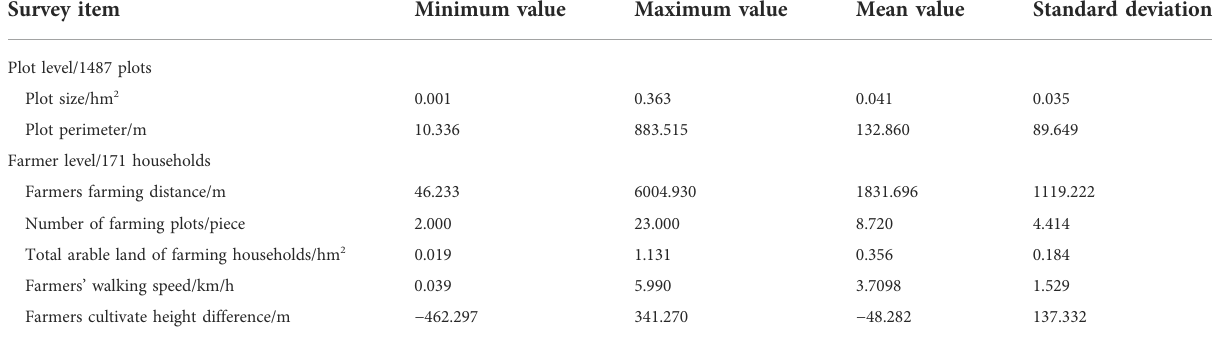
TABLE 1 Descriptive statistics of farming household survey